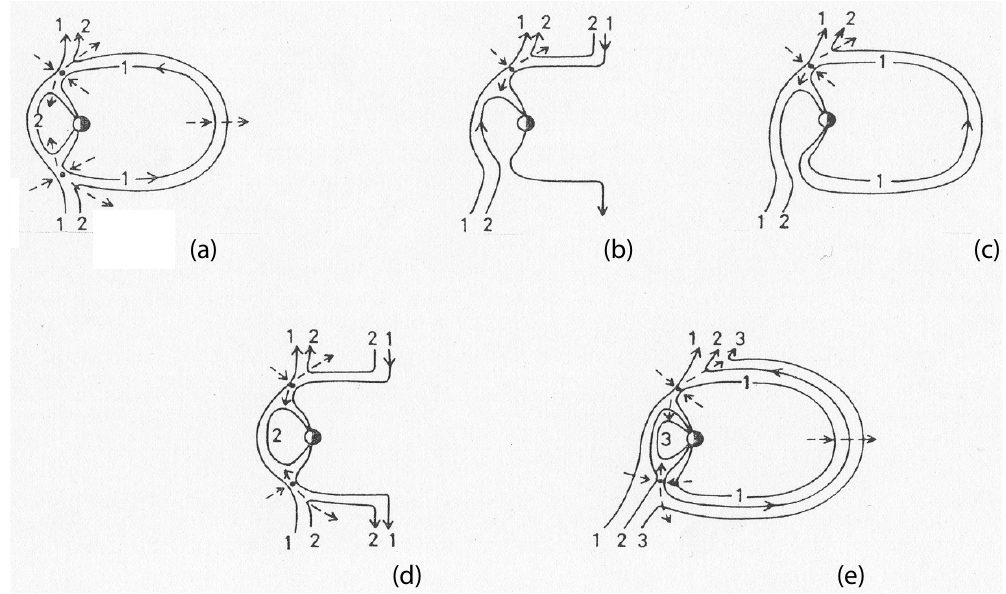
Fig. 1. Cowley’s (1981, 1983) pictorial presentation of five different physically possible topologies for lobe reconnection during Northward